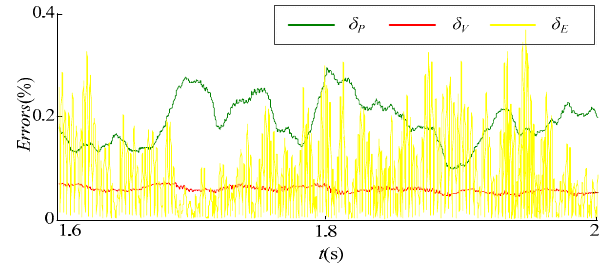
Figure 9. Relative errors of P, V and E.